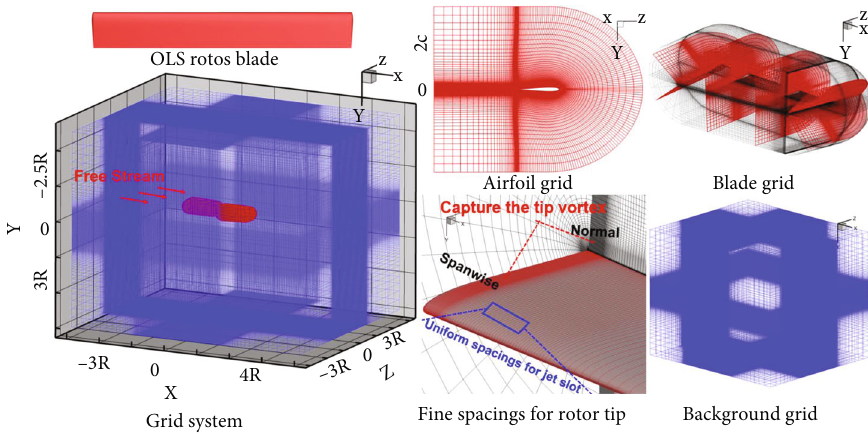
Figure 1: Grid system used for the nonblowing baseline case and the blowing cases.